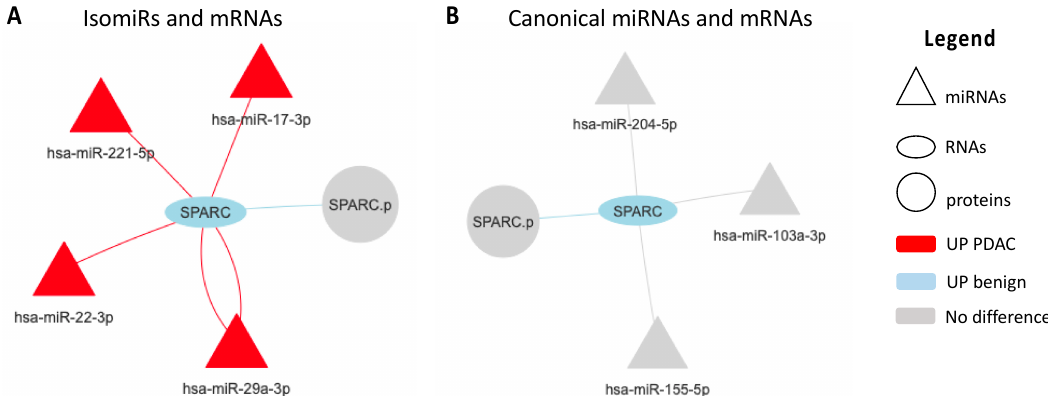
Figure 3. Networks focused on SPARC and based on correlation analyses of miRNAs, RNAs and proteins in PDAC platelets. A node-to-node connection is only seen if the nodes satisfy the expected correlation rule (negative correlation between miRNA and mRNAs, and positive correlation between mRNAs and proteins). ( A ) expected correlations between isomiRs and mRNA data; ( B ) expected correlations between canonical miRNAs and mRNA data; In isomiRs data each connection represents one isomiRs type, red and light blue colors represent up-regulation in PDAC and benign platelets, respectively. Triangle, oval and circle represents miRNAs, RNAs and proteins, respectively.